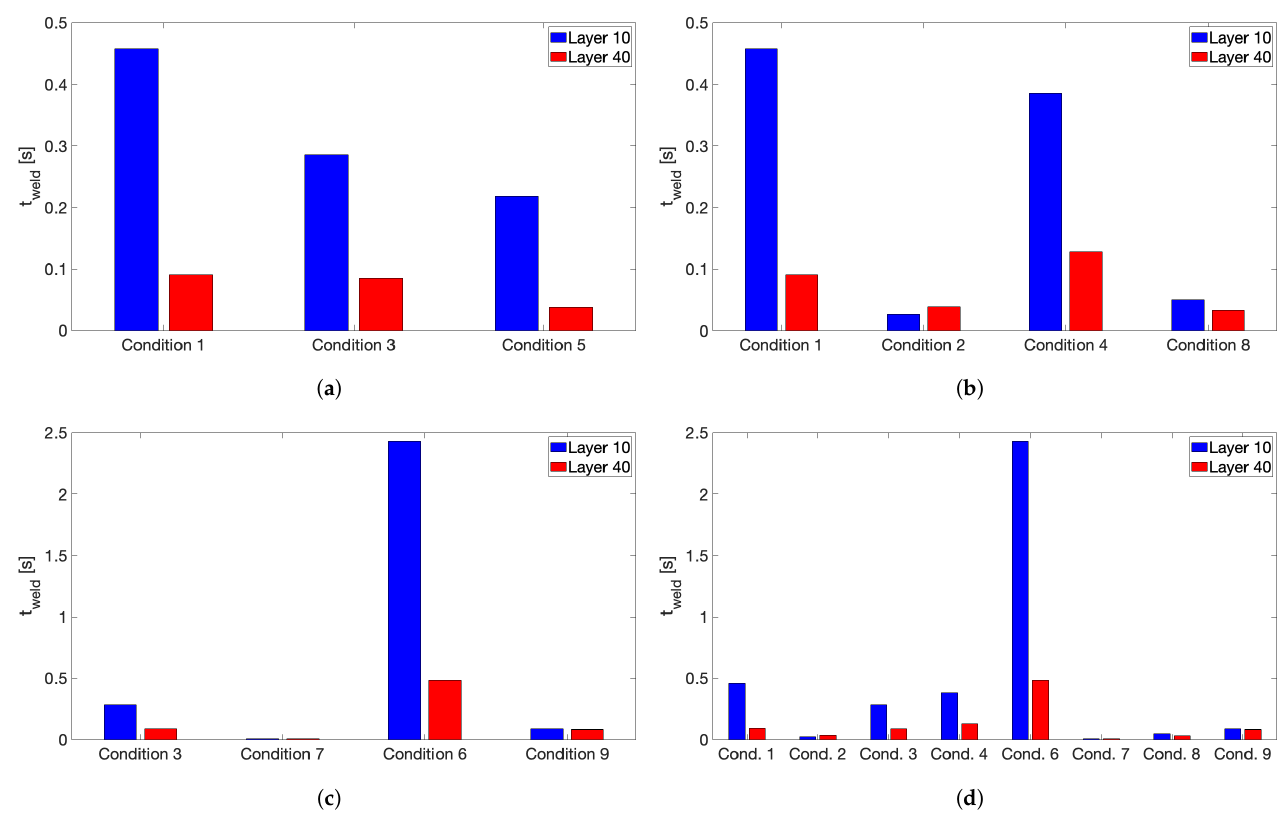
Figure 8. An overview of the calculated equivalent isothermal weld times t weld for all printing conditions. ( a ) Effect of T liquefier = 260, 240 and 220 °C for conditions 1, 3 and 5, respectively. ( b ) Effect of v print = 11 mm/s for conditions 1 and 2, and 5.5 mm/s for conditions 4 and 8. ( c ) Effect of M w . HMWPA for conditions 3 and 7 and LMWPA for conditions 6 and 9. ( d ) Effect of T build plate = 110 °C for conditions 1, 3, 4 and 6, and 40 °C for conditions 2, 7, 8 and